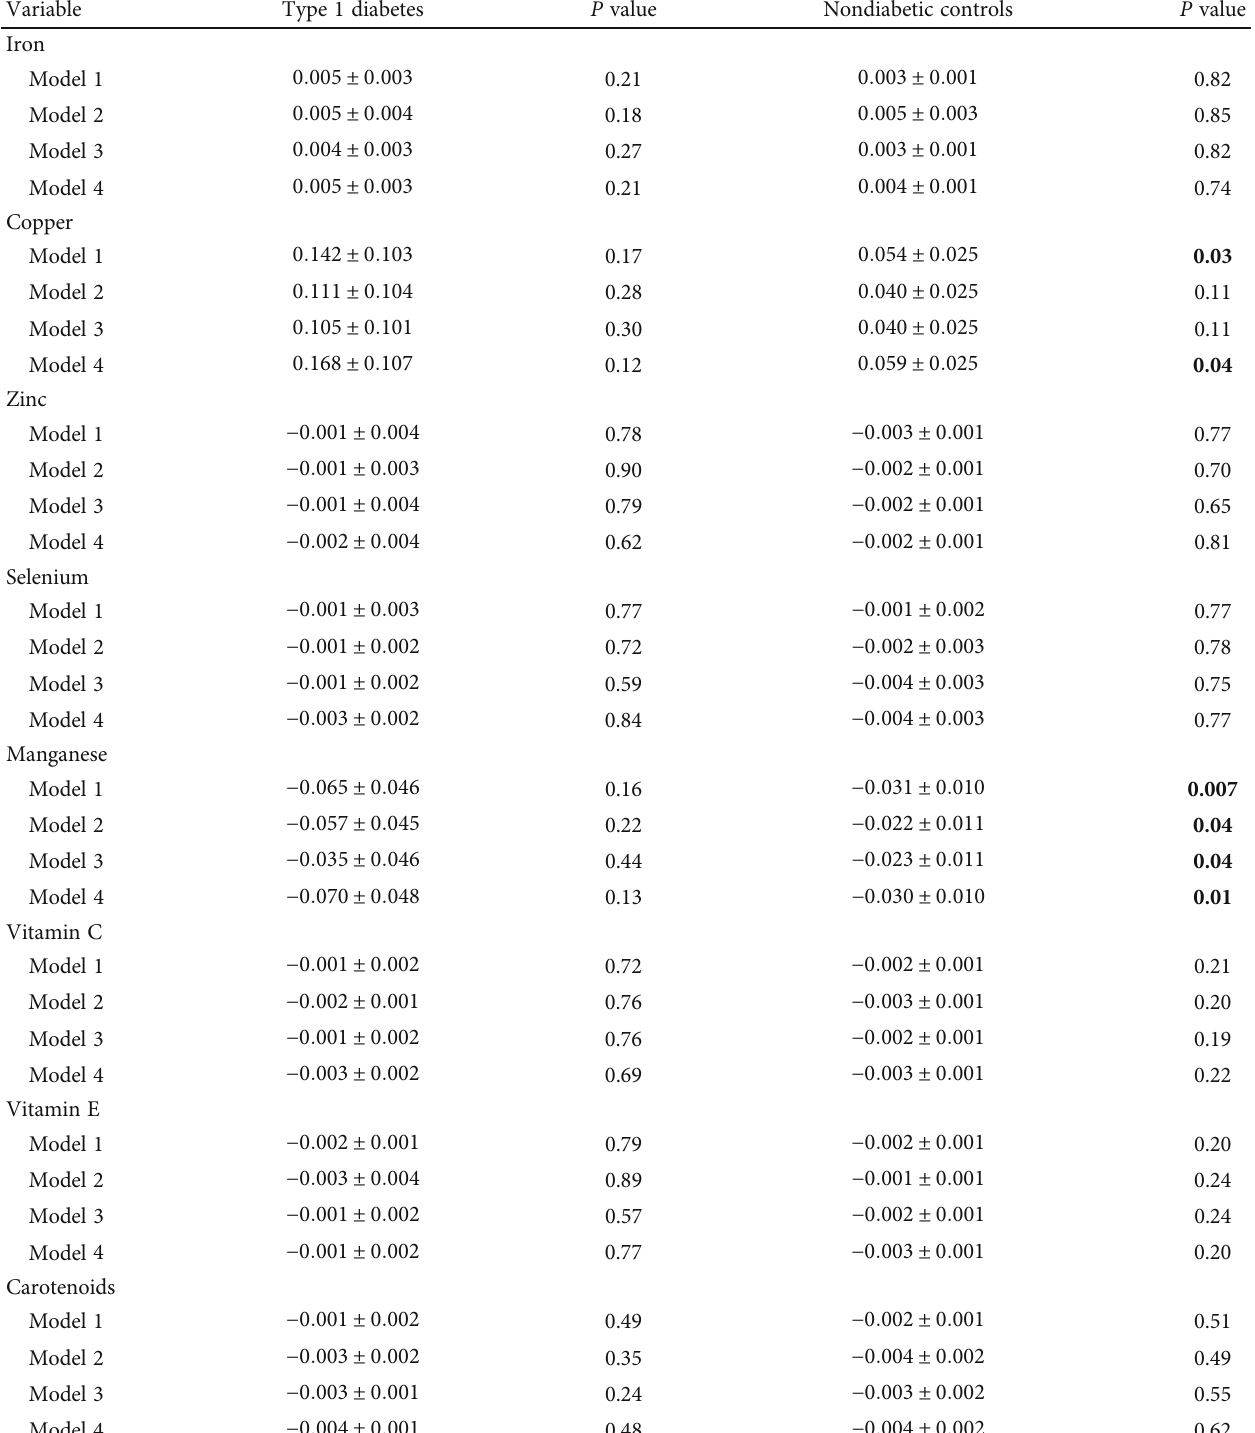
Table 2: Cross-sectional associations of dietary antioxidant micronutrients with glycated hemoglobin (HbA1c) ( β ± standard error ). Variable Type 1 diabetes P value